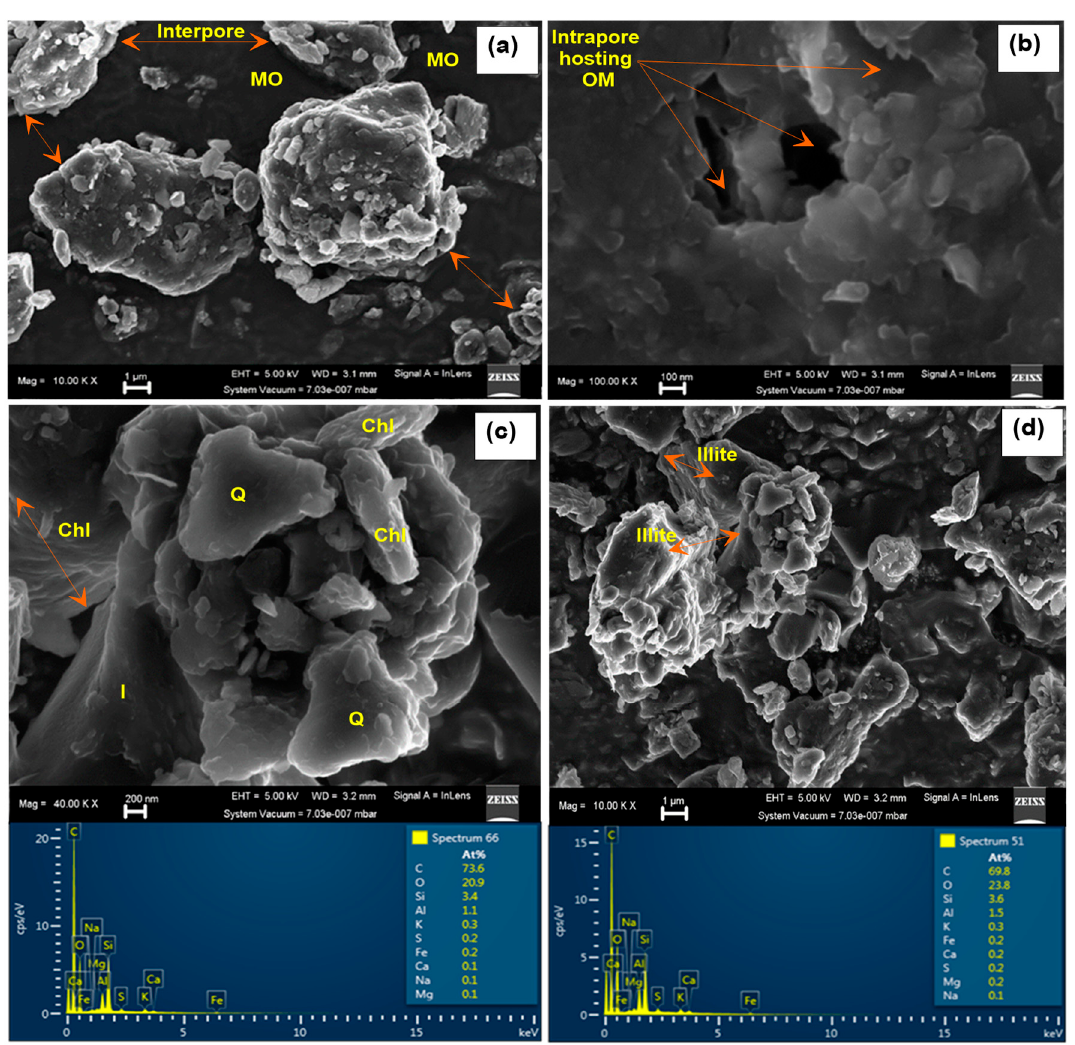
Figure 5. SEM images of the studied carbonaceous shale showing ( a ) intergranular pores hosting OM, ( b ) intragranular pores hosting OM, ( c ) SEM images of Chlorite ‐ chl, Quartz ‐ Q, Illite ‐ I minerals, and ( d ) veinlet of Illite minerals.